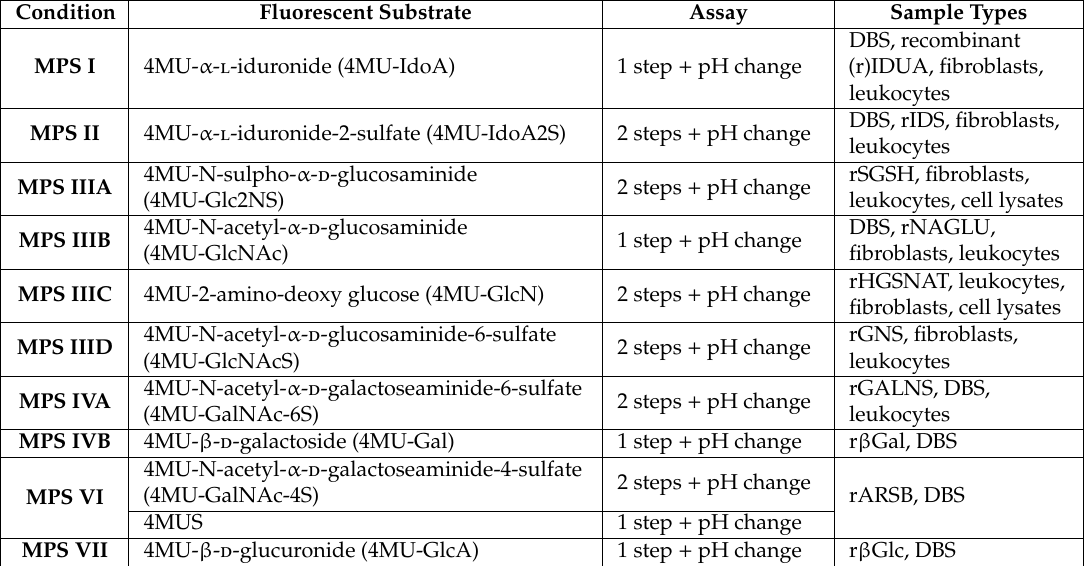
Table 2. Summary of the fluorescent substrates, assay formats, and samples analyzed using MPS enzyme activity